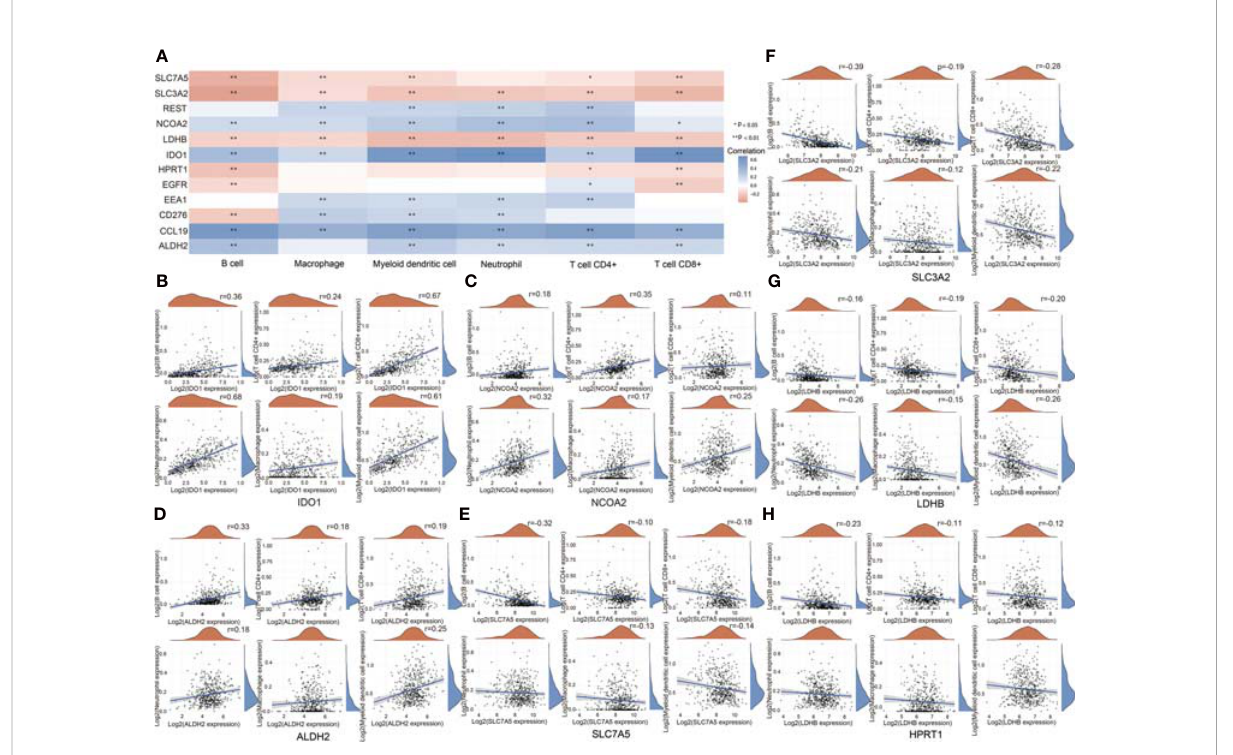
FIGURE 8 Analysis of relationships between prognosis-related genes and immune in fi ltrates. (A) Relationships between prognosis-related genes and immune in fi ltrates in HNSCC. (B) Relationships between IDO1 and immune in fi ltrates in HNSCC. (C) Relationships between NCOA2 and immune in fi ltrates in HNSCC. (D) Relationships between ALDH2 and immune in fi ltrates in HNSCC. 9 (E) Relationships between SLC7A5 and immune in fi ltrates in HNSCC. (F) Relationships between SLC3A2 and immune in fi ltrates in HNSCC. (G) Relationships between LDHB and immune in fi ltrates. (H) Relationships between HPRT1 and immune in fi ltrates in HNSCC. (*P < 0.05; **P <